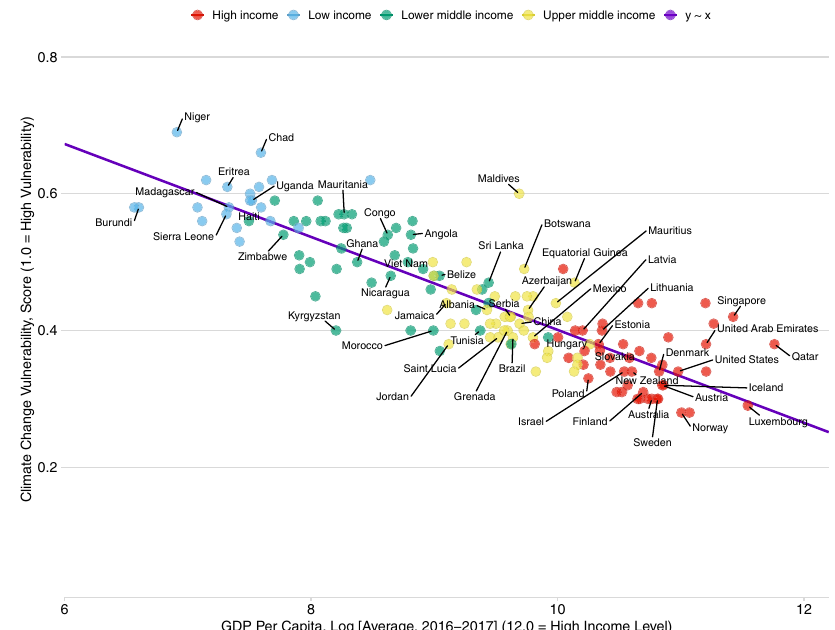
Fig. 6 Linear relationship between GDP per capita and climate change vulnerability. This plot captures income convergence (i.e., high income, low income, lower middle income, and upper middle income) of sampled economies based on average annual